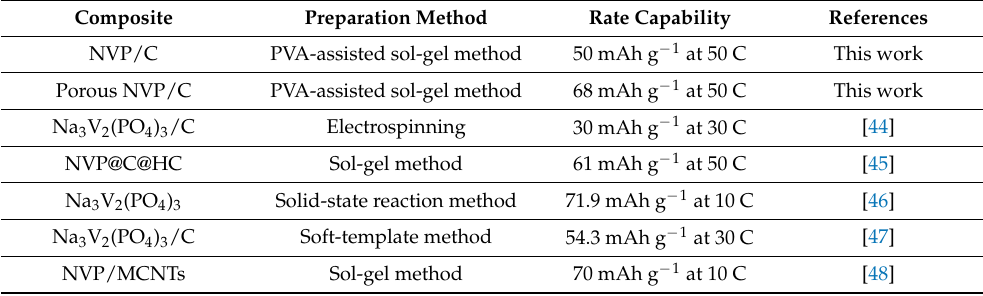
Table 1. Comparison of the rate capabilities of NVP cathodes between this work and other reports.